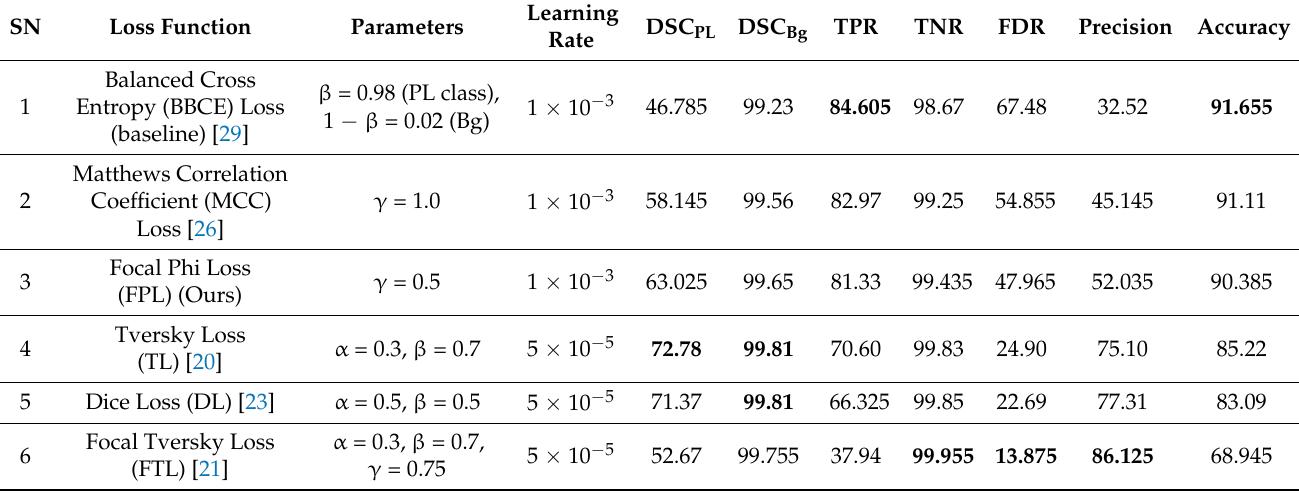
Table 3. Experimental results comparison of various loss functions on Mendeley PL validation dataset with 80 images.